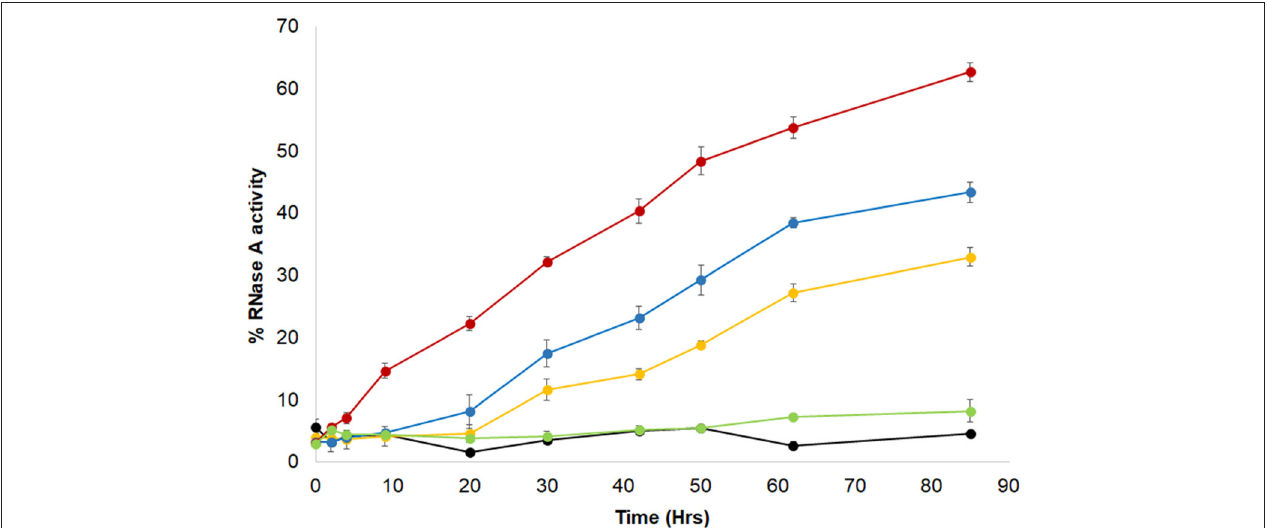
FIGURE 2 | ZnJ2 affects the oxidative refolding of reduced and denatured RNaseA. RNaseA (10 mg/ml) was denatured in the presence of 150mM DTT and 6M guanidine hydrochloride. Refolding of the reduced and denatured RNaseA was initiated by its dilution (200-fold) into renaturation buffer to a final concentration of 50 µ g/mL (3.8 µ M). Refolding was either spontaneous ( • ) or conducted in the presence of 5 ( • ), 10 ( • ), or 30 µ M ( • ) ZnJ2 or 5 µ M citrate synthase as a negative control that replaced ZnJ2 ( • ), that served as a negative control. Aliquots were removed at various intervals and transferred into the assay mixture. RNaseA activity was measured by monitoring the hydrolysis of cytidine 2 ′ :3 ′ -cyclic monophosphate at 284nm. The percentage of refolding was calculated relative to native RNaseA activity. Similar results were obtained in three independent replicate experiments.